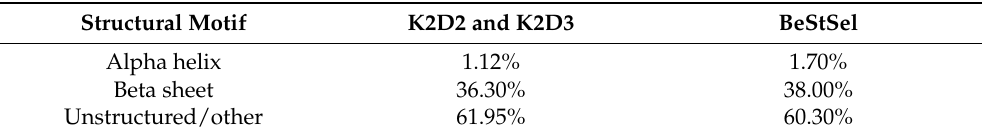
Table 2. Structural motive comparison, calculated from online applications using the curve shown in Figure